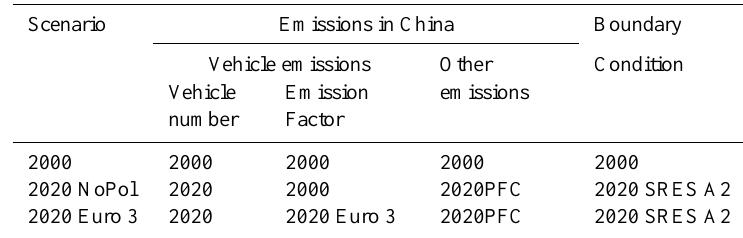
Table 5. List of WRF/Chem